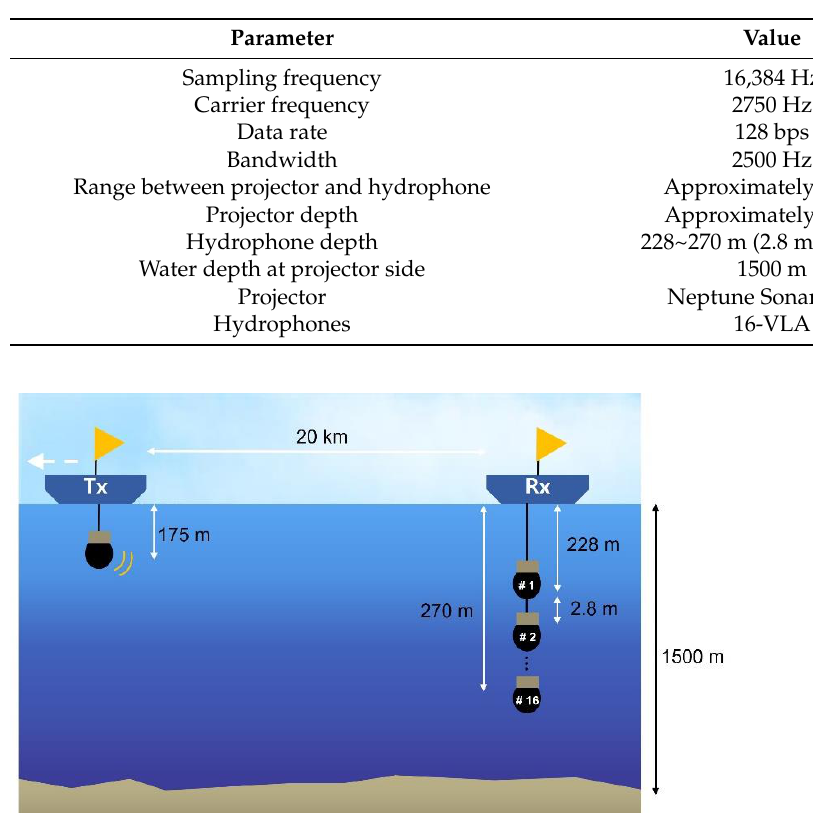
Figure 10. Configuration for sea trial .